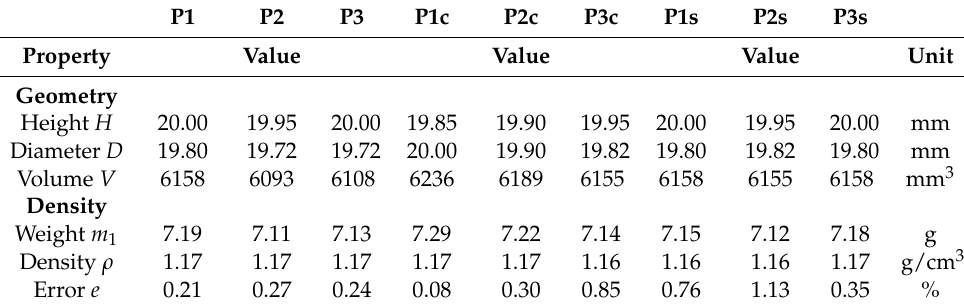
Table 5. Specimen qualifications made with